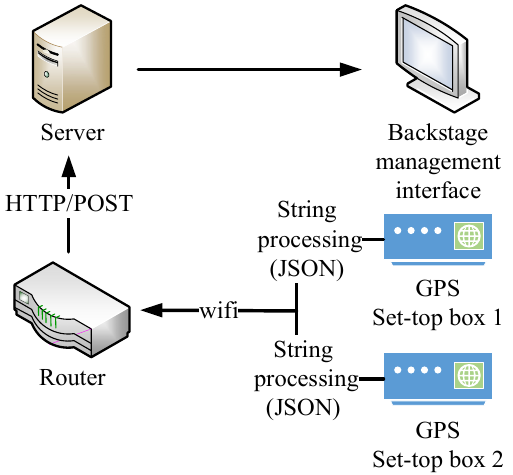
Figure 6. STB data transfer process.